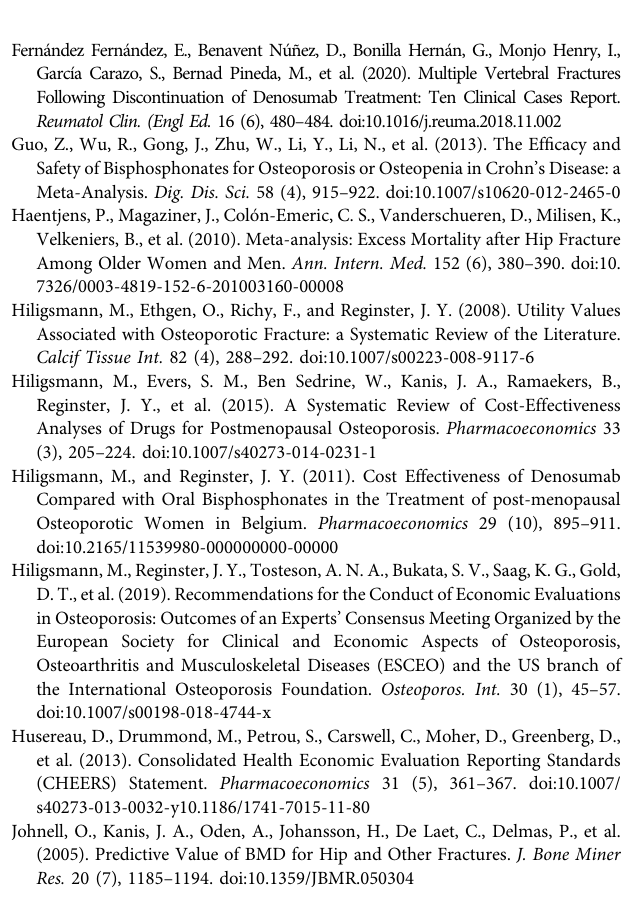
Supplementary Figure S1 | Results of Probabilistic Sensitivity Analyses, age 65 years. Supplementary Figure S2 | Results of Probabilistic Sensitivity Analyses, age 70 years. Supplementary Figure S3 | Results of Probabilistic Sensitivity Analyses, age 75 years. Supplementary Table S1 | Summary of key parameters in the model. Supplementary Table S2 | Results of one-way analyses at 70, 75, and 80